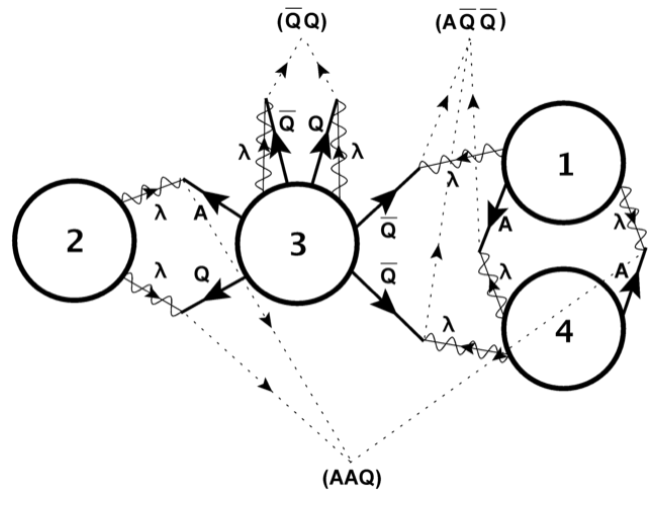
Figure 8: A sketch of the instanton contribution to the three-point function of gauge invariants for F = 2 in the 3D, R → 0 limit.